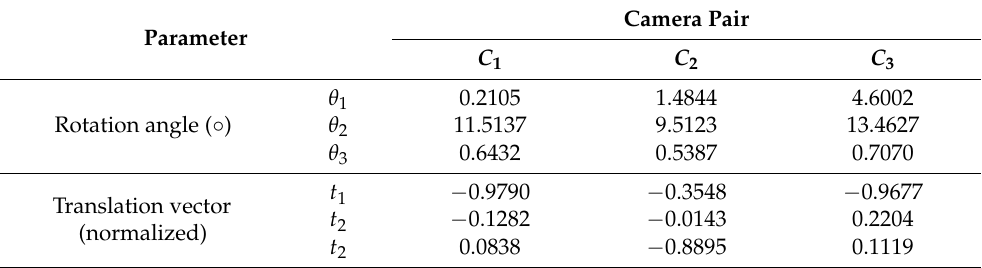
Table 2. Extrinsic parameters determined by proposed